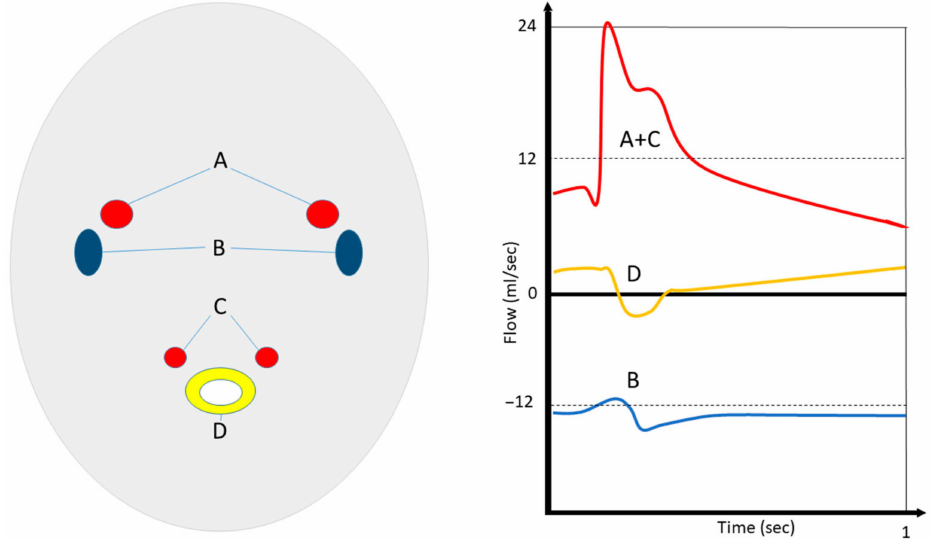
Figure 3. Concept of MR-ICP. Simultaneous (in and out) flow measurements of internal carotid (A) and vertebral (C) arteries, as well as venous flow in the jugular veins (B) and cerebrospinal fluids at the C2 level (D), enable the estimation of cerebral compliance, pressure gradients, and ICP. (Schematic overview made by S.J.